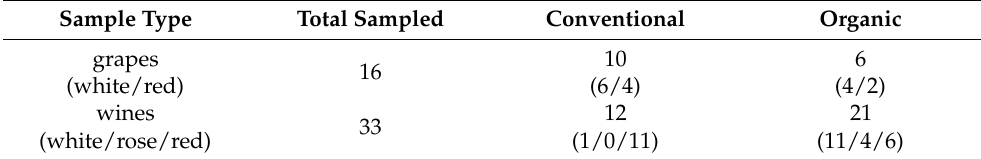
Table 1. The overview of analyzed